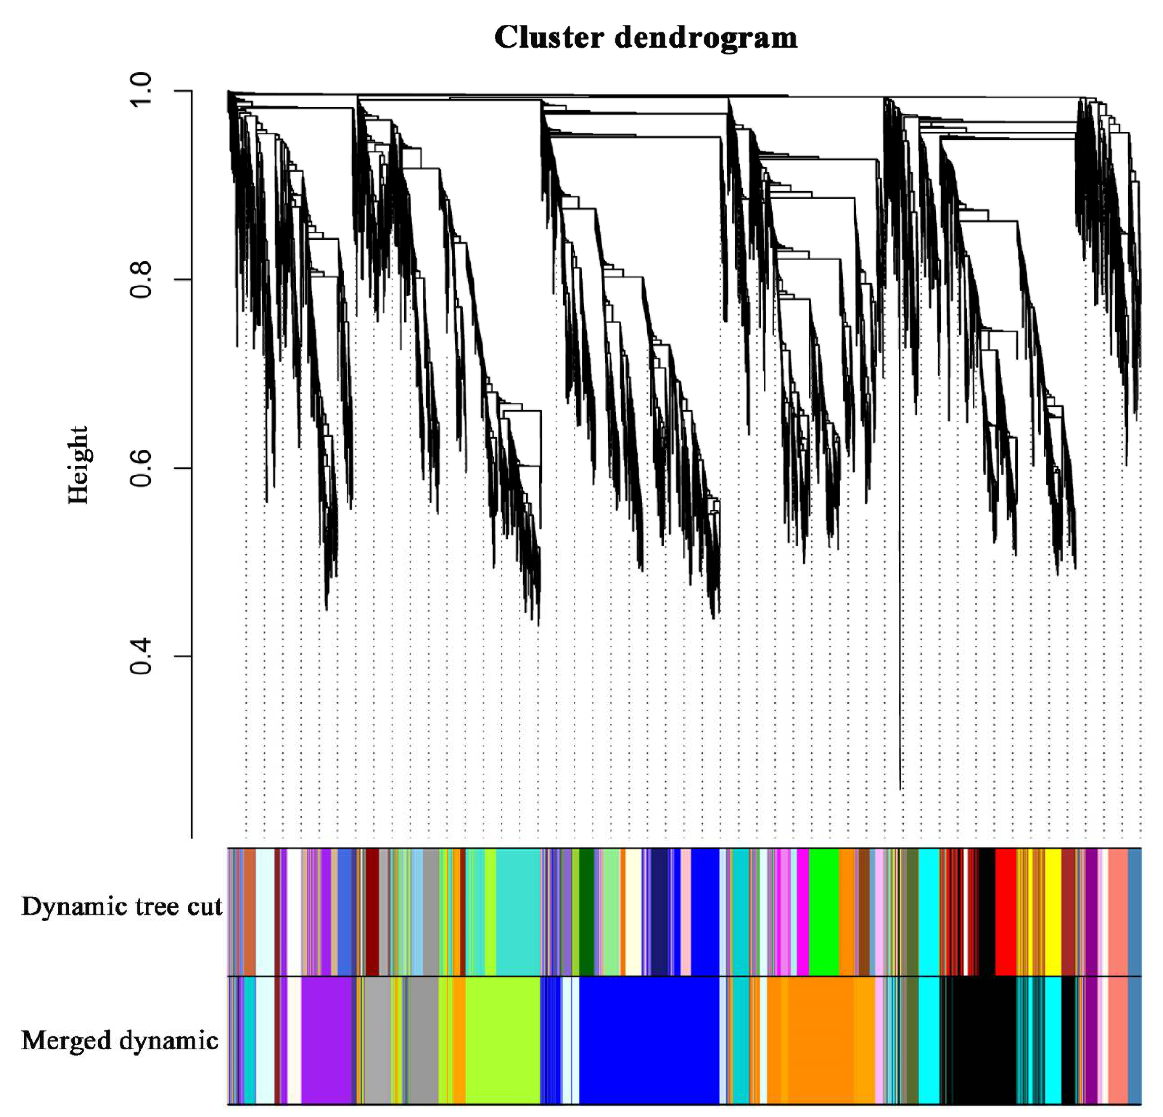
Figure 7. Clustering dendrograms of genes. Dissimilarity was based on topological overlap, together with assigned module colours. The 23 co-expression modules are shown in different colours.